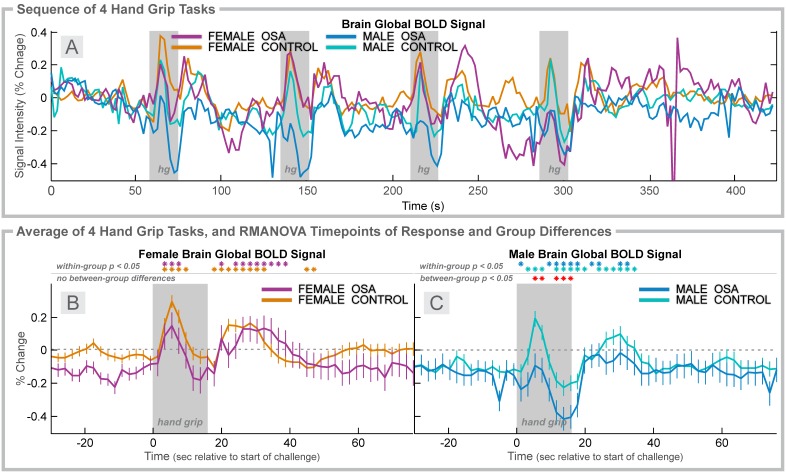
Hand grip, 4 group.Time courses, separated by sex, of global BOLD signals over four hand grip challenges (Grip effort; gray rectangles). A: Average global BOLD signal in females (6 OSA, 20 control) and males (31 OSA, 37 control) during the complete sequence. For females (B) and males (C), average over four challenges of change in global BOLD signals relative to baseline (group mean ± SE), with time-points of significant increase or decrease relative to baseline within-group, and time-points of between-group differences (RMANOVA, p<0.05).